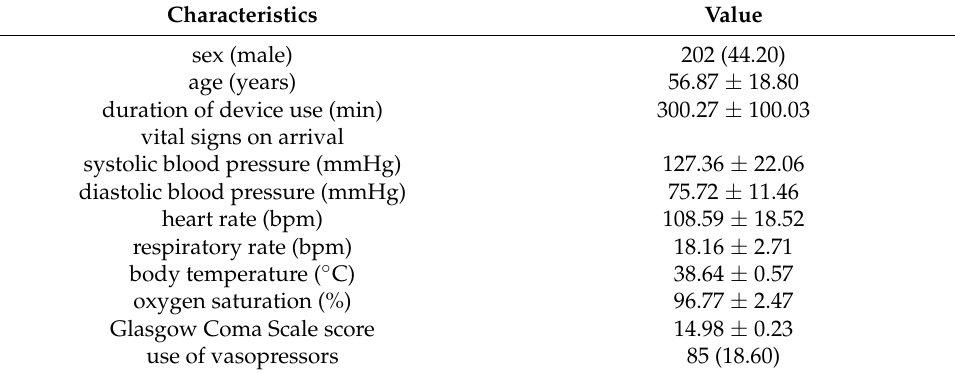
Table 1. Baseline characteristics of the enrolled patients .